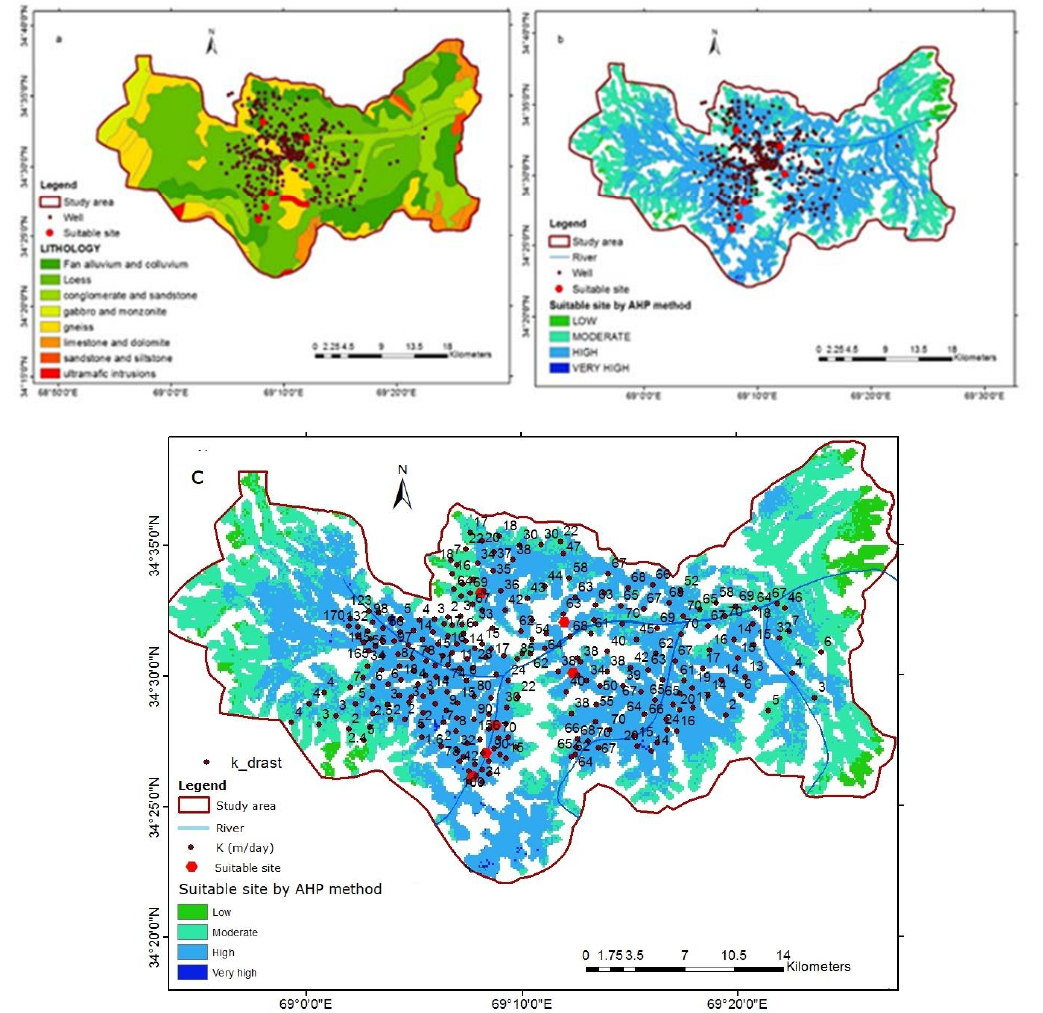
Figure 11. Lithological maps showing location of: ( a ) extraction wells and suitable sites to recharge identified by previous studies; ( b ) groundwater recharge potential zones by AHP method and established extraction wells and suitable sites; ( c ) hydraulic conductivity, k (m/day), distribution in the study area.